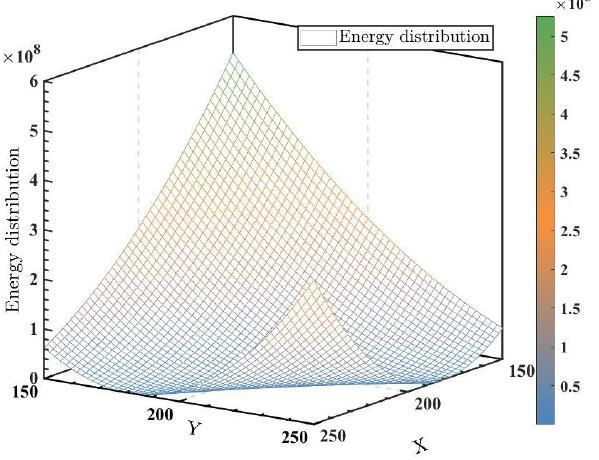
Figure 4. Energy distribution of the system H = ( X × Y − 45431 ) 2 .